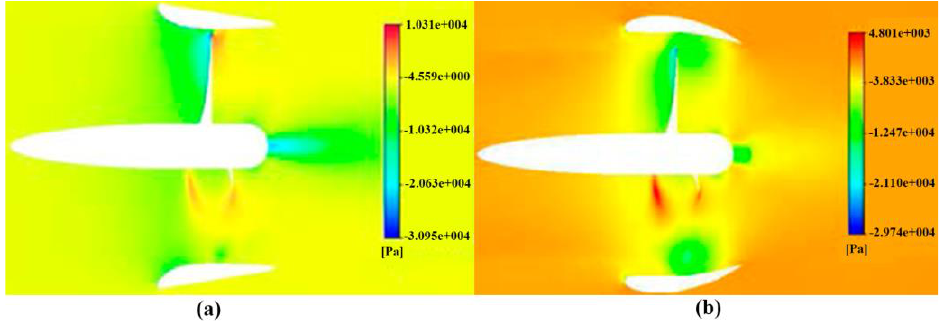
Figure 19. Flow-field pressure contour of the accelerating duct ( a ) and decelerating duct ( b ).